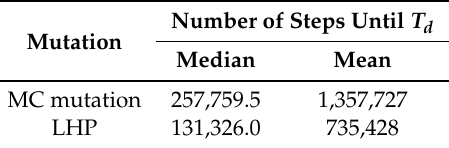
Table 1. Numbers of global optimization steps until the true T d global minimum is found, comparing local heat pulse (LHP) and standard Monte-Carlo (MC) as main mutation operators.